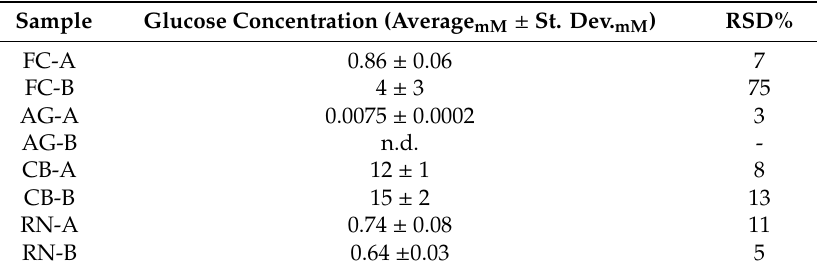
Table 3. The glucose concentration in C-GMs samples.